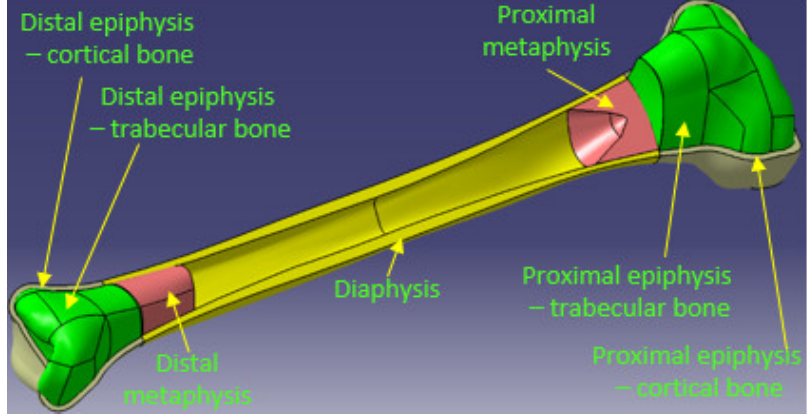
Figure 5. Section in human tibia—assembly of the entities.